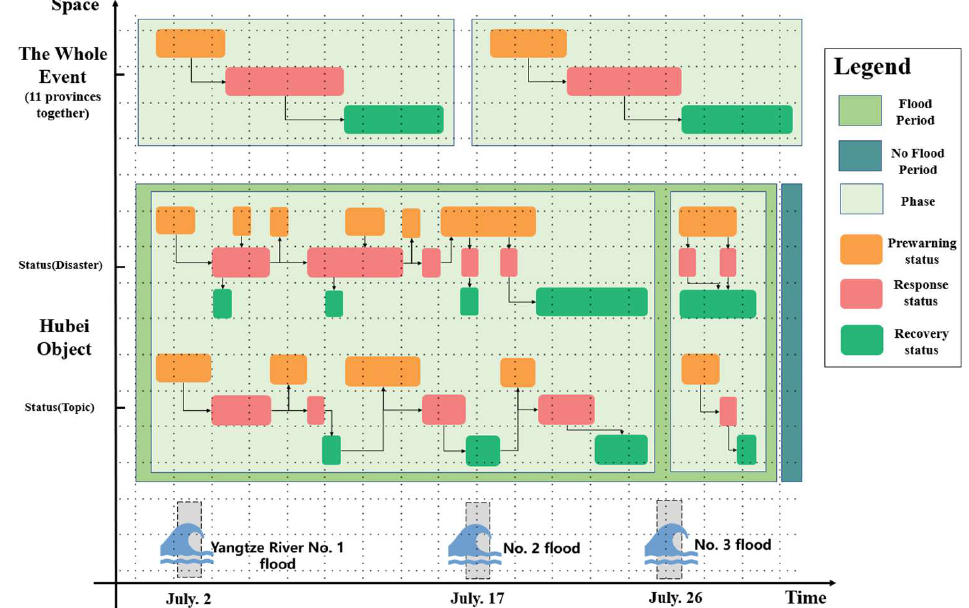
Figure 14. Experimental procedure of the case study.